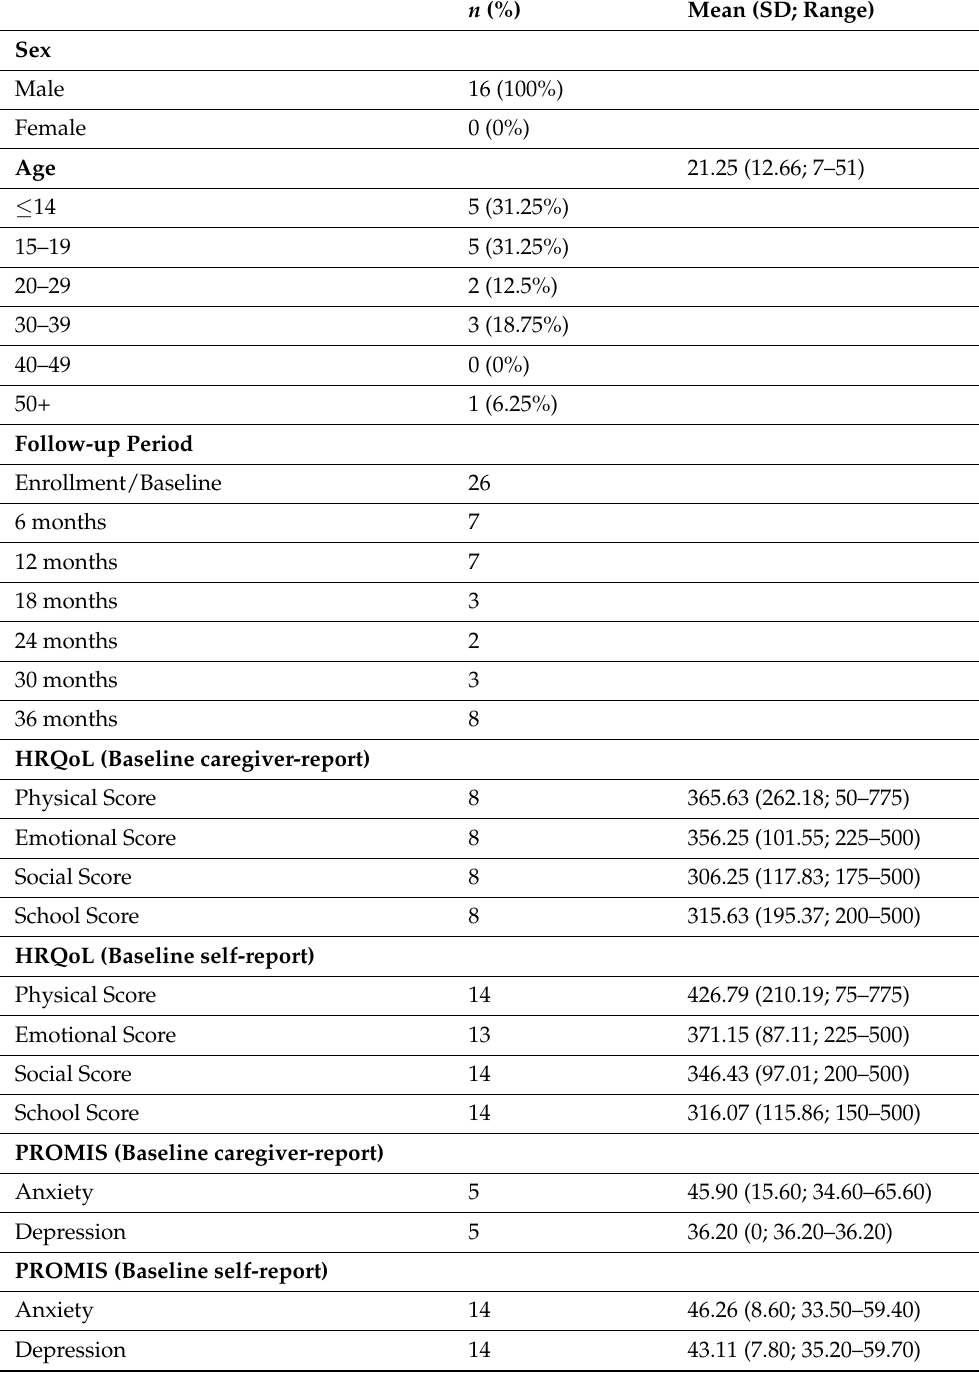
Table 1. Participant